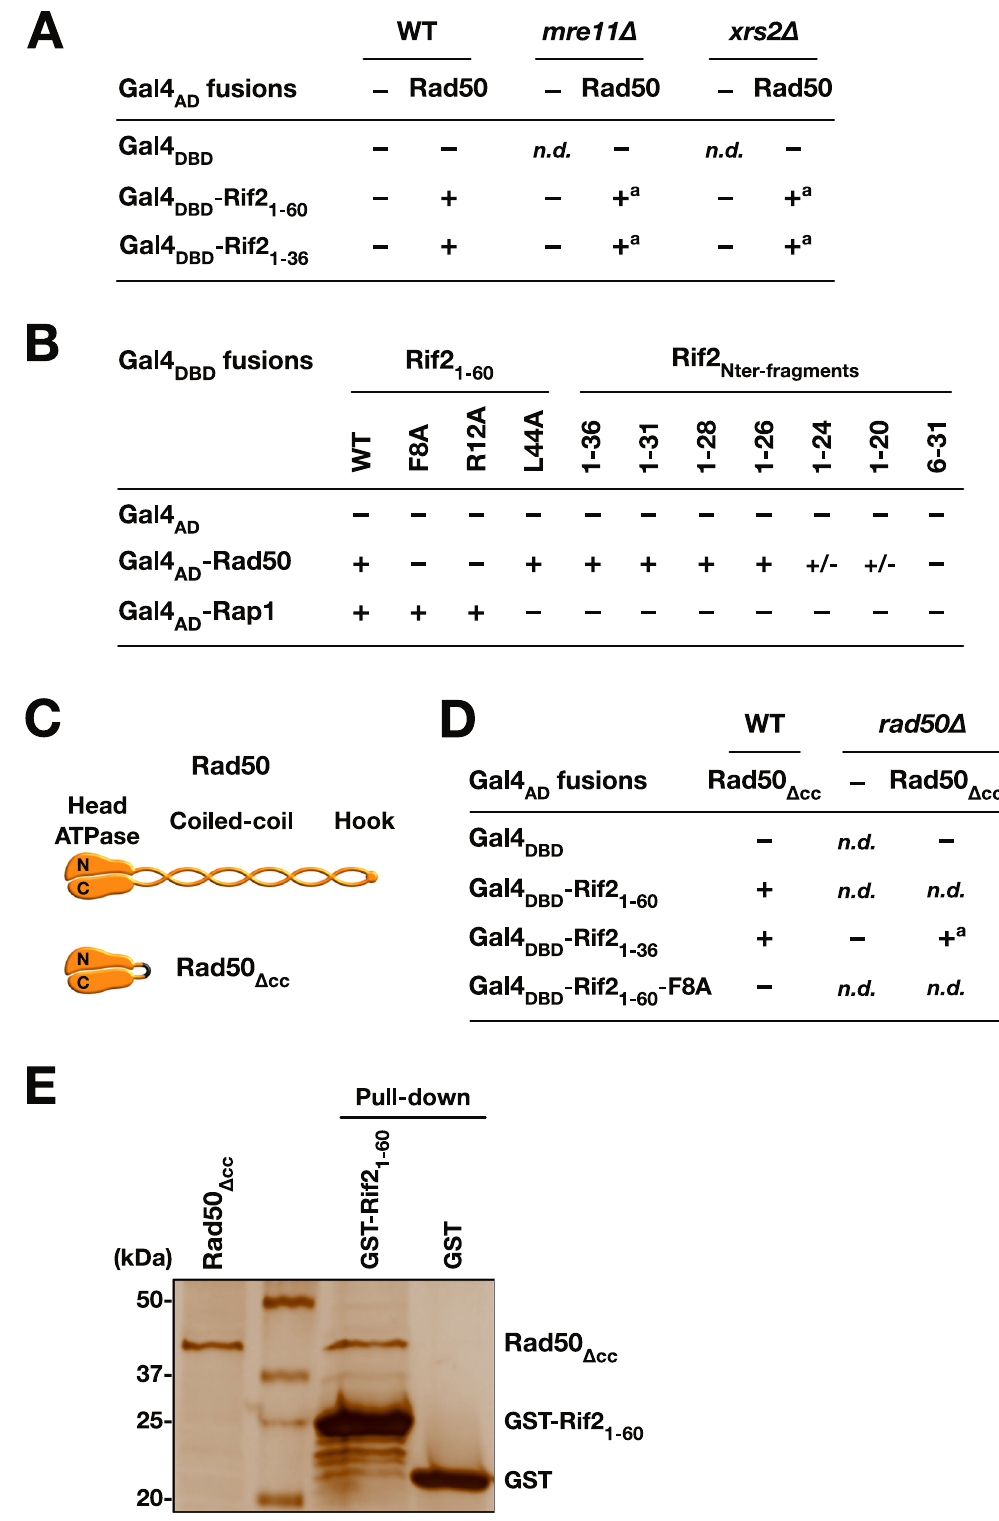
Fig. 4 Rif2 BAT interacts with Rad50 ATPase Heads in vivo. A 2-Hybrid interactions between Rif2 N-terminal region and full-length Rad50 in WT cells and in cells lacking Mre11 and Xrs2 ( − no growth on plates supplemented with 3-AT, + growth on plates supplemented with 3-AT). A : slow growth in MRX-defective cells. B 2-Hybrid interactions between Rif2 N-terminal region and full-length Rad50 or Rap1 (fragment 366 – 827) in WT cells ( + /- slow growth on plates supplemented with 3-AT). C Representation of full-length Rad50 and of the Rad50 Δ CC fragment lacking the coiled-coil arm. D 2-Hybrid interactions between Rif2 N-terminal region and Rad50 ATPase Head in WT cells and in cells lacking the endogenous Rad50. E GST pull-down interaction between Rif2 N-terminal region and Rad50 ATPase Head. Experiment reproduced three